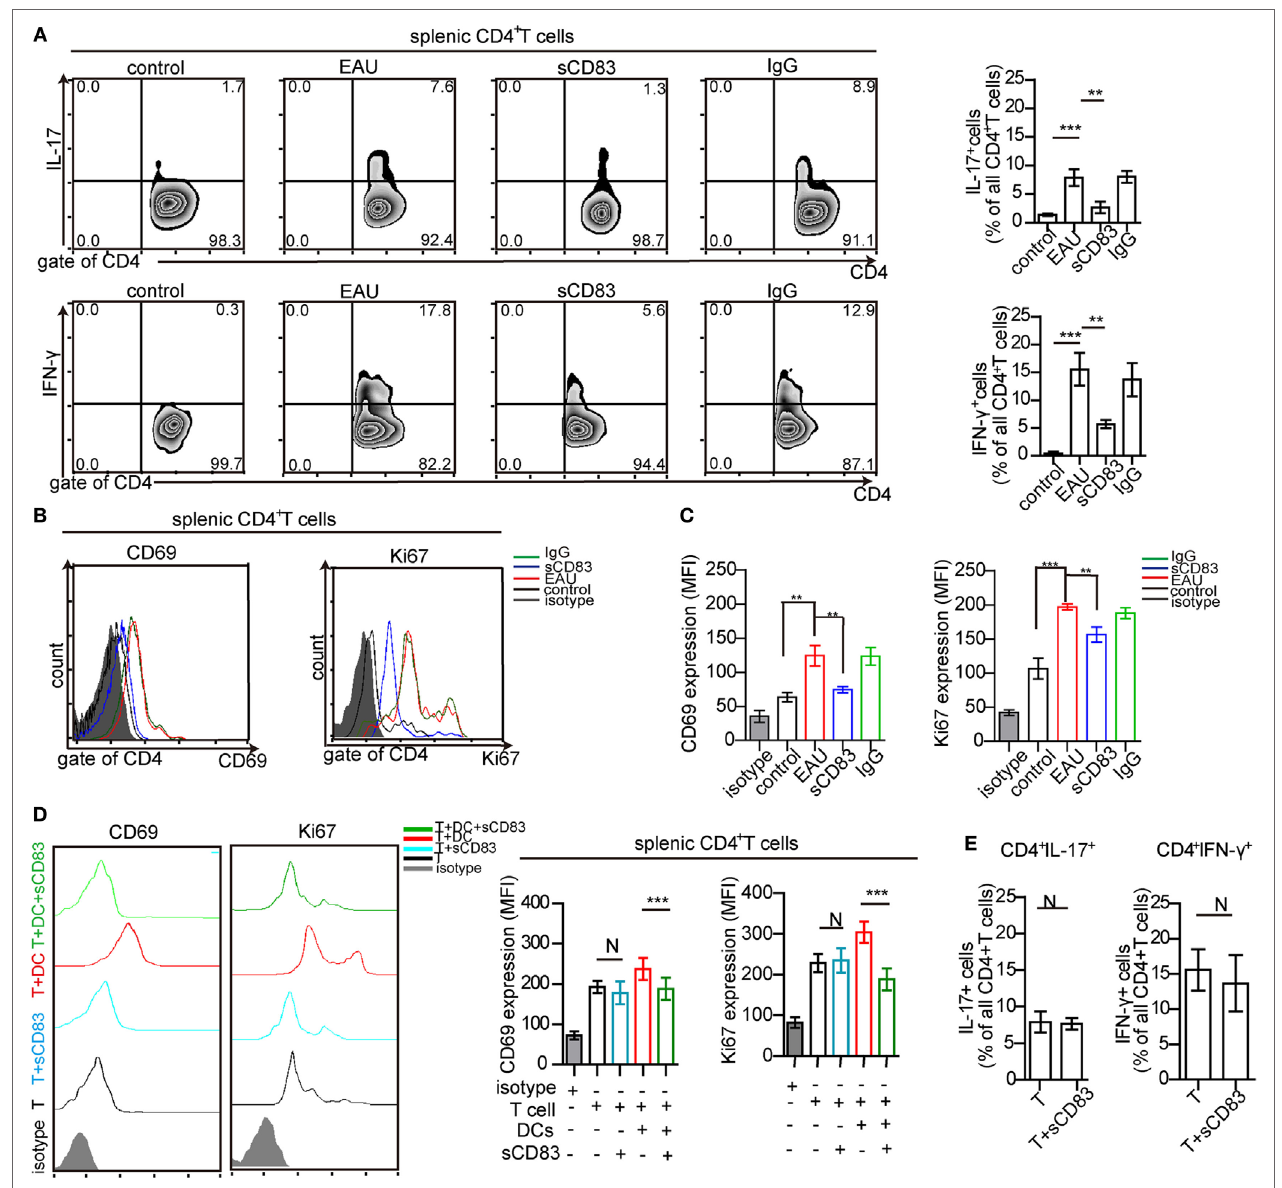
FigUre 4 | Soluble CD83 (sCD83) inhibits CD4 + T cell activation in vivo but not in vitro . (a) Abundance of CD4 + IL-17 + (type 17 helper T cells) and CD4 + IFN- γ + (type 1 helper T cells) cells in the spleen as determined by flow cytometry in experimental autoimmune uveitis (EAU), i.v. sCD83-treated mice, IgG 1 -treated mice, and control mice. (B,c) The expression of CD69 and Ki67 in splenic CD4 + T cells (B) and the mean fluorescence intensity (MFI) (c) were analyzed by flow cytometry. Data shown in (a–c) are from n = 20 in triplicates. Mean ± SEM, one-way ANOVA LSD- t test. *** p < 0.001, ** p < 0.01. (D) CD69 and Ki67 expression of splenic CD4 + T cells in co-culture experiments with different conditions: splenic CD4 + T cells of EAU mice (T), T cells with sCD83 treatment (T + sCD83), co-culture of T cells with interphotoreceptor retinoid-binding protein peptide 1–20 (IRBP 1–20 )-pulsed mature dendritic cell (DC) (T + DC), and co-culture of T cells with sCD83- pretreated IRBP 1–20 -pulsed mature DC (T + DC + sCD83). The MFI of CD69 and Ki67 in these T cells is shown in the right histograms. n = 5, N: not significant, one-way ANOVA LSD- t test. (e) Flow cytometry of CD4 + IL-17 + and CD4 + IFN- γ + T cells (% of total CD4 + T cells) with and without sCD83 treatment. n = 5, mean ± SEM, N: no significant, two-tailed Student’s t -test. *** p <